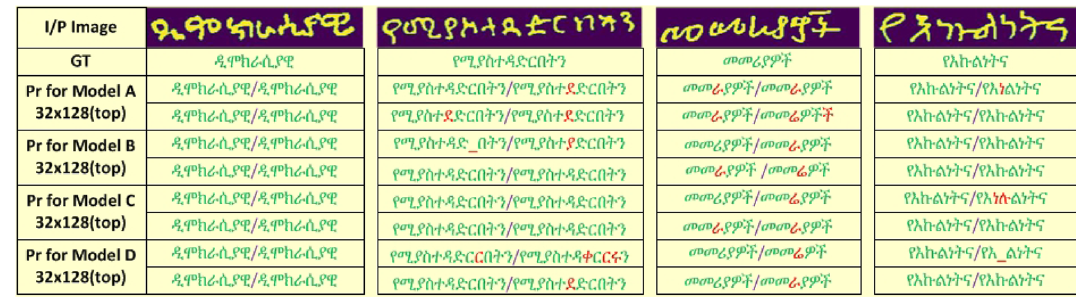
Fig. 4 Recognition Results of the different models on sample test set word images. Here GT refers to ground truth label and Pr refers to recognized text by the model. For each respective recognition model the top row indicates results obtained by using input word